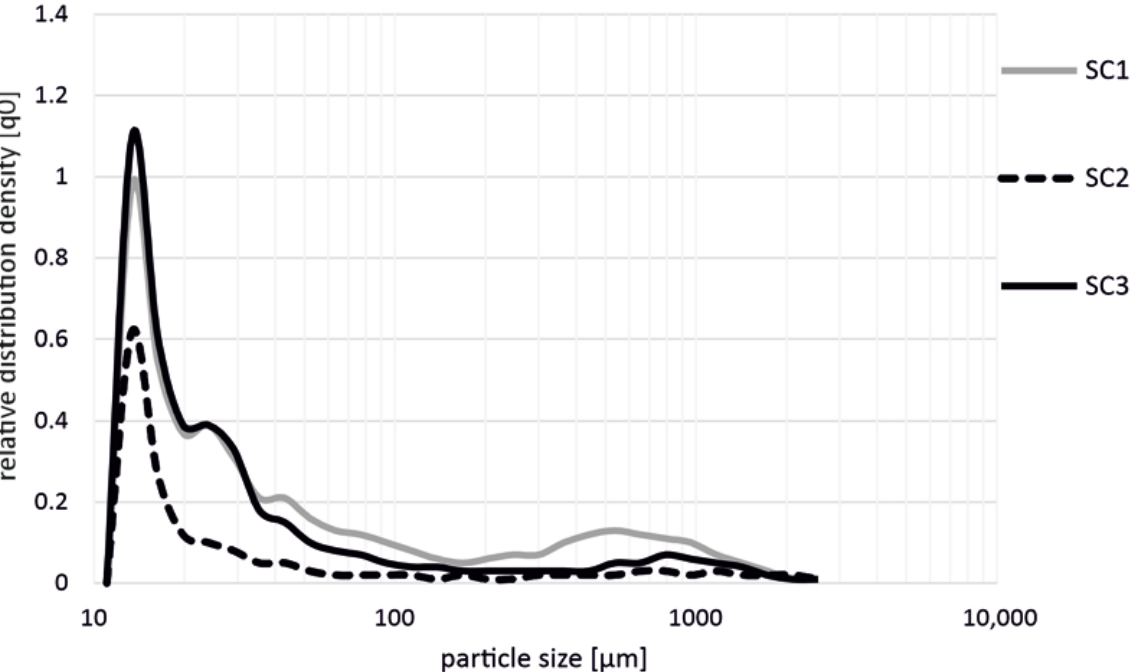
Figure 2. Influence on fiber length during the production of PP GF 20 with different screw configurations (SC1, SC2, SC3) in the extrusion process.